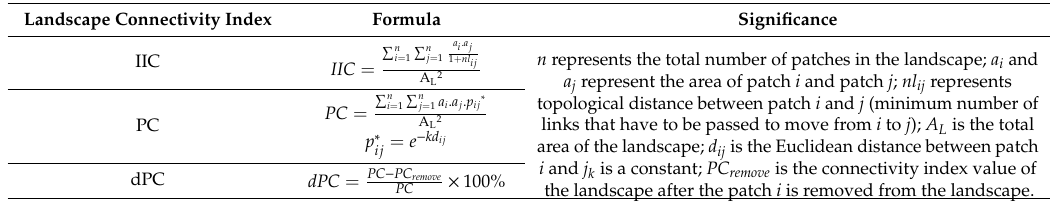
Table 3. Connectivity